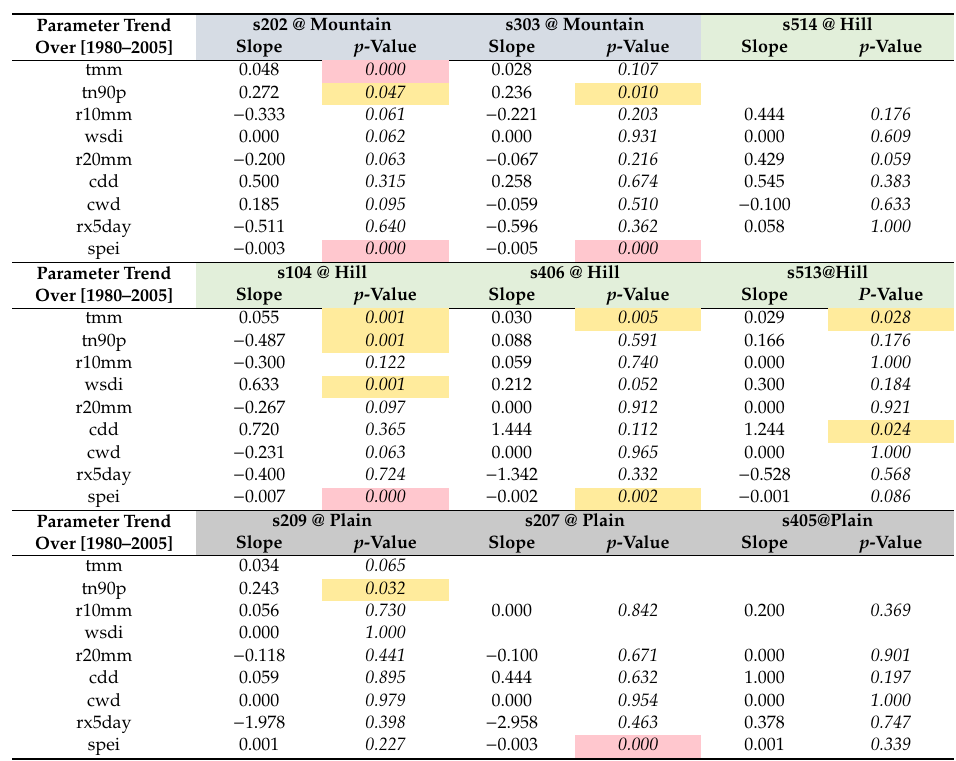
Table A4. Climatological trends in nine ET-SCI climatic indices. Slope is Sen’s slope and p -value